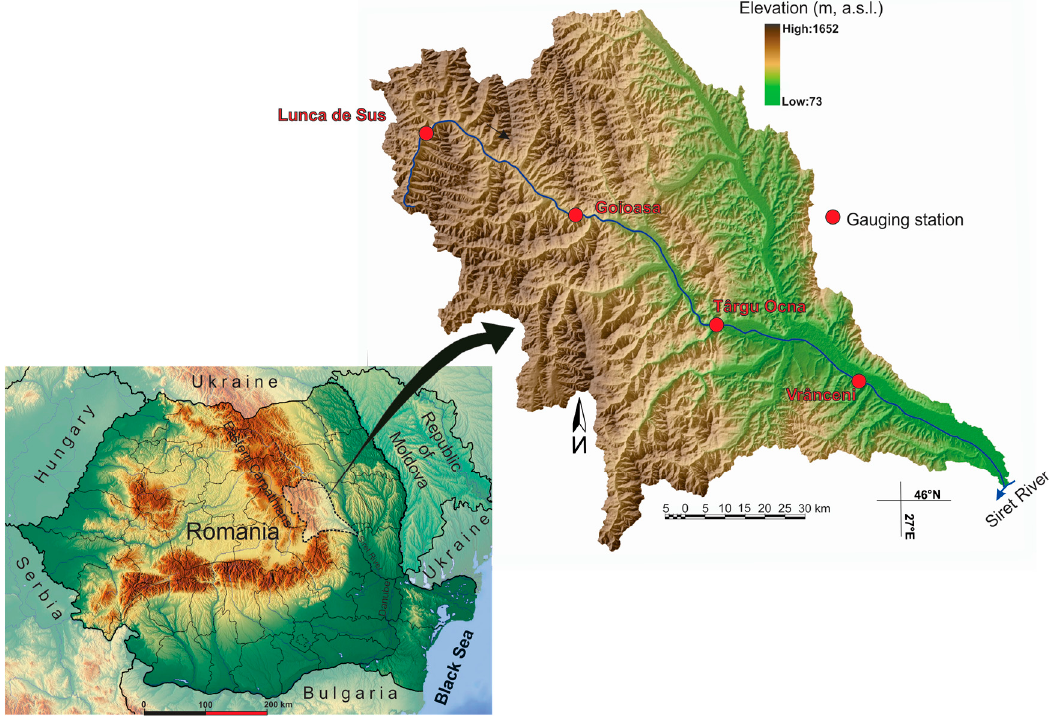
Figure 1. Location of the study area in the Eastern Carpathians and locations of discharge and sediment gauging stations; data from these stations were used for this study.